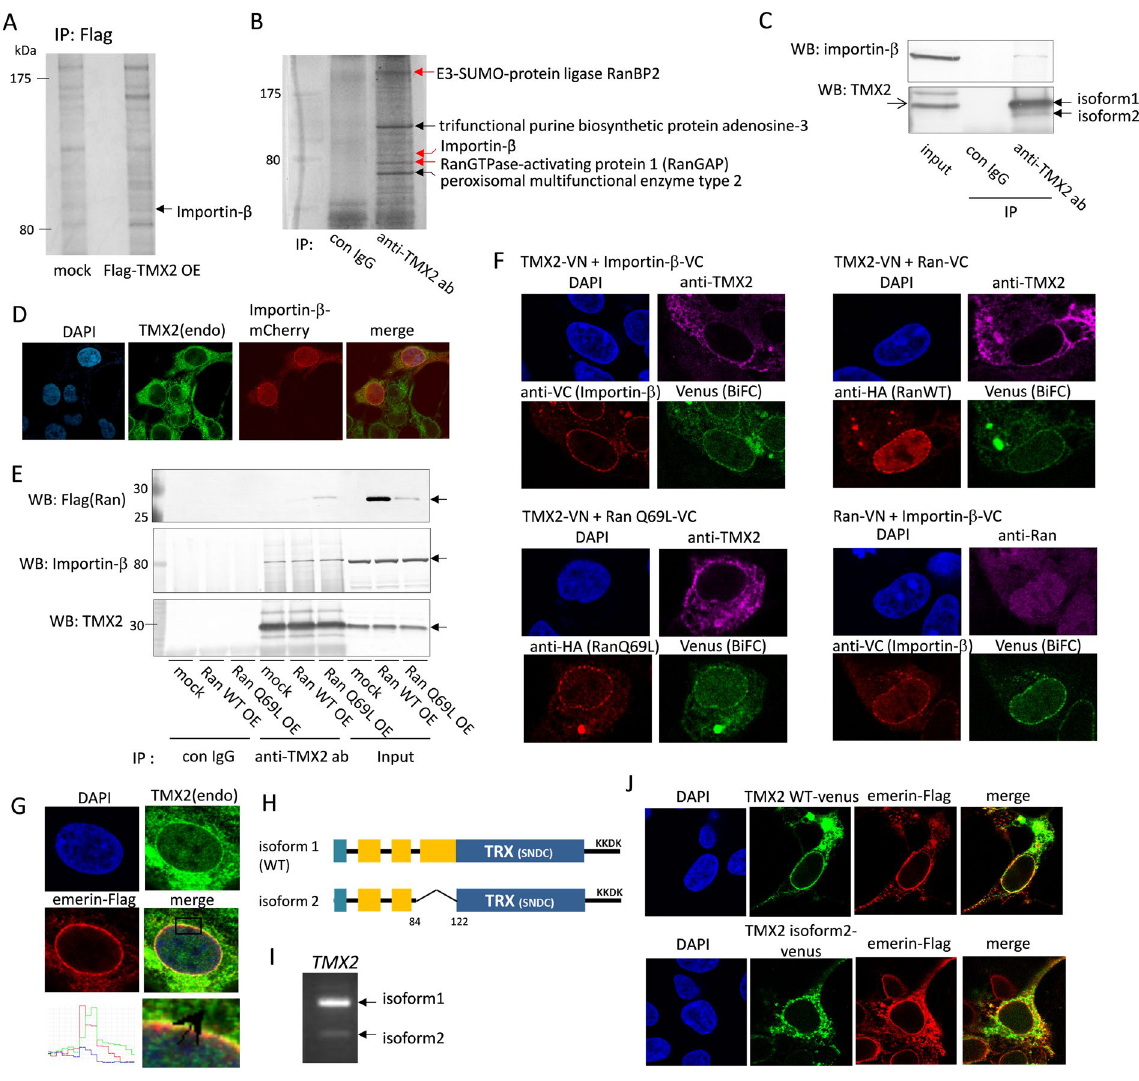
Figure 1. TMX2 interacts with nuclear import protein. ( A ) Flag-TMX2 was overexpressed in HEK293 cells and immunoprecipitated with anti-Flag antibody. The band indicated by the arrow was analyzed by LC-MS. ( B ) Endogenous TMX2-intereacting proteins in HEK293 cells were immunoprecipitated with anti-TMX2 antibody and analyzed by LC-MS. ( C ) HEK293 cell lysates were immunoprecipitated with anti-TMX2 antibody and analyzed by western blot with anti-importin- β antibody. ( D ) mCherry-importin- β was expressed in HEK293 cells and immunostained with anti-TMX2 antibody. ( E ) Flag-Ran WT or -Ran Q69L mutant was overexpressed in cells and immunoprecipitated with anti-TMX2 antibody. ( F ) TMX2-VN was co-expressed with importin- β -VC, HA-RanWT-VC, or HA-RanQ69L-VC in HEK293 cells, and the overexpression of these proteins were confirmed by anti-TMX2, anti-VC, or anti-HA antibody. Venus fluorescence as BiFC signal indicates the interaction of these fusion proteins. BiFC signal was also detected by co-expression of Ran-VN and importin- β -VC as a positive control. ( G ) Co-localization of endogenous TMX2 and Flag-emerin was analyzed by immunofluorescence. ( H ) A diagram of TMX2 WT and isoform 2, which lacks part of the transmembrane region. ( I ) TMX2 WT and isoform 2 cDNA were amplified by PCR from HEK293 cDNA with the primer sets at 191–507th of TMX2 WT nucleotide. ( J ) Venus fused with TMX2 WT or isoform 2 was expressed in HEK293 cells, and co-localization with emerin-Flag was